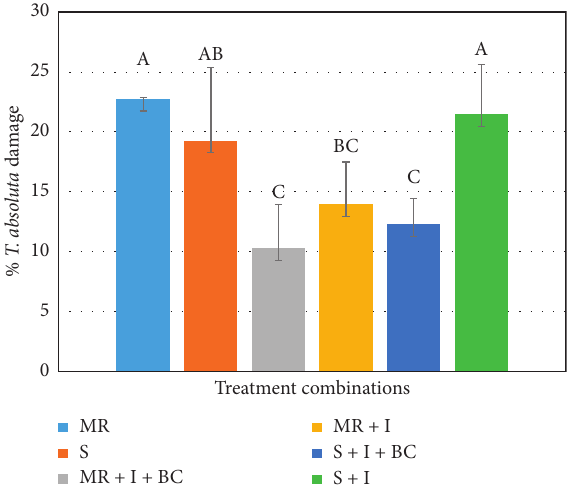
Figure 1: Effect of different treatment combinations on T. absoluta